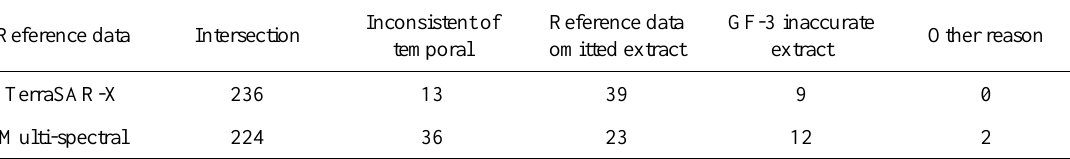
Table 10. Differential Analysis of GF-3 data and reference data